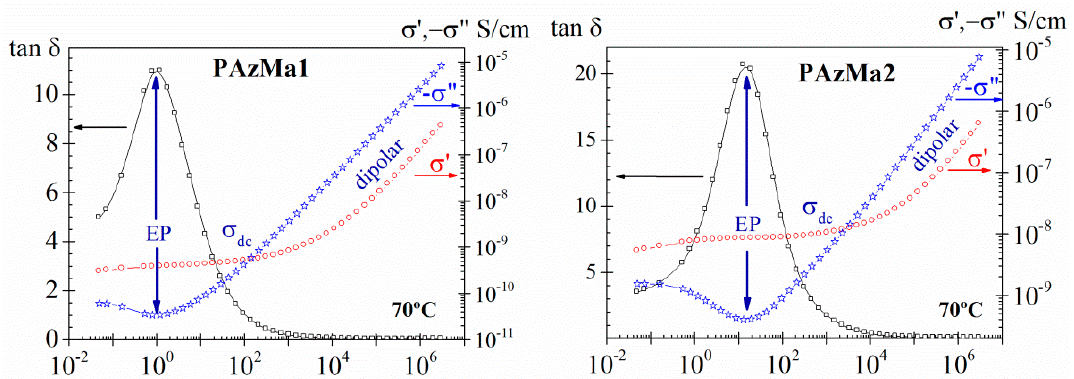
Figure 9. Frequency dependence of tan δ and of the real ( σ ’ ) and imaginary ( − σ ” ) parts of the complex conductivity ( σ *) for PAzMa1 and PAzMa2 at 70 °C.